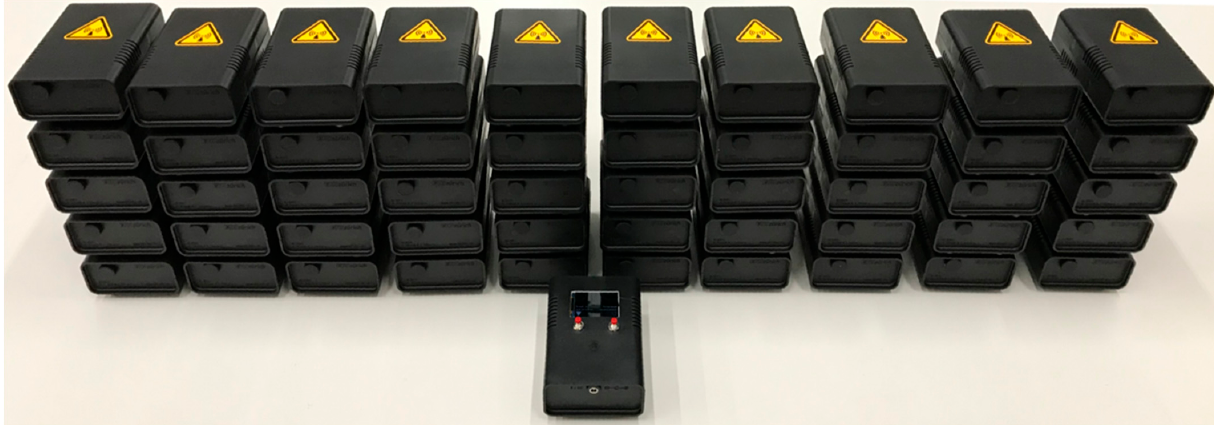
Figure 1. All 50 assembled sensor nodes with the reference unit in